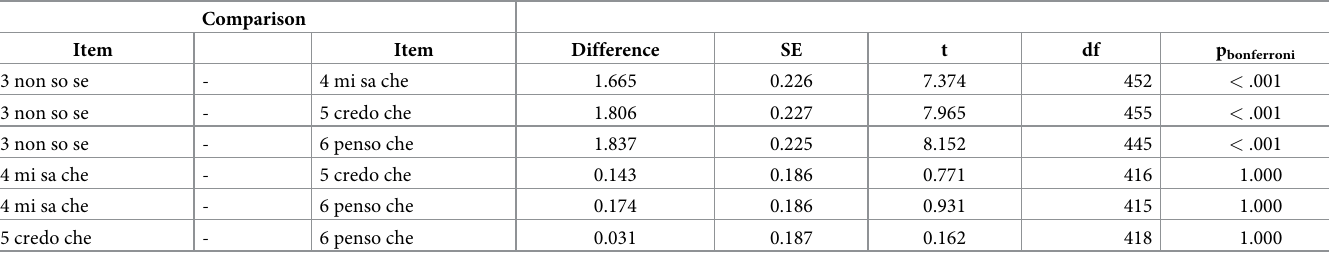
Table 4. Bonferroni-post-hoc comparison of the four sentences. Comparison